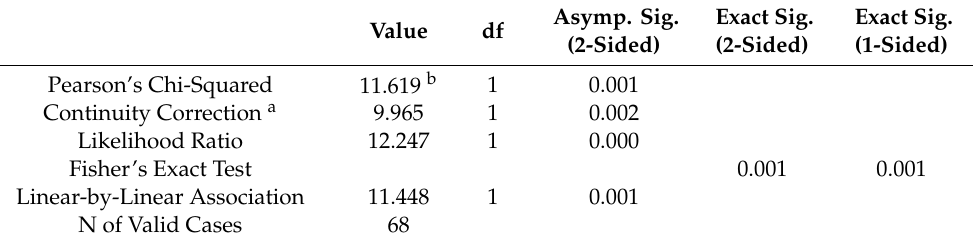
Table 13. Results of Pearson’s chi-squared test of independence. Asymp. Sig. Value df